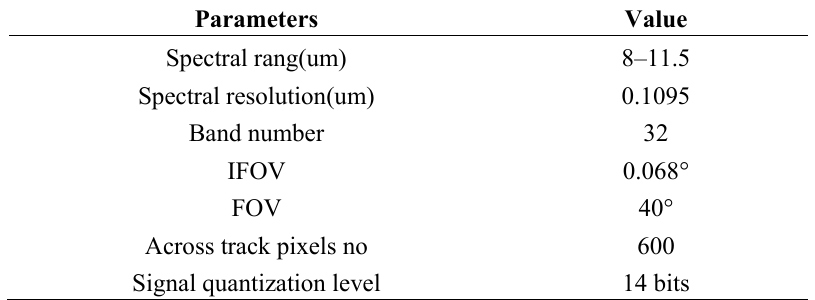
Table 1. Thermal Airborne Spectrographic Imager (TASI) sensor characteristics.